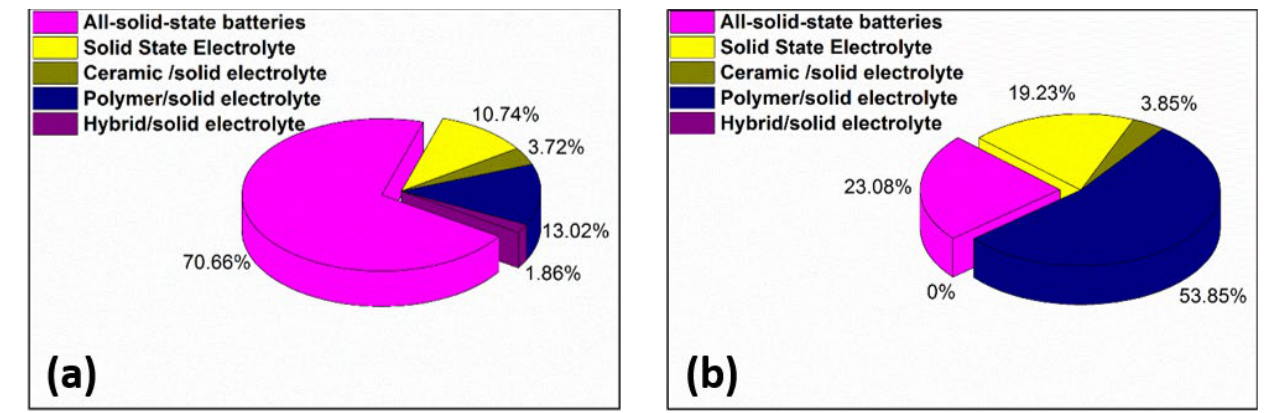
in the past two decades.